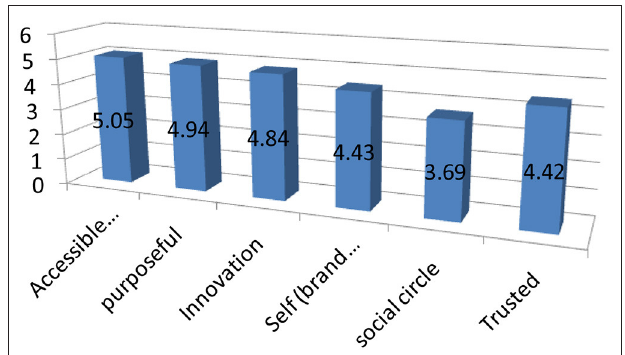
FIGURE 2 | Ranking of consumer perception of mindset variables that influence their brand preference, based on a Likert Scale